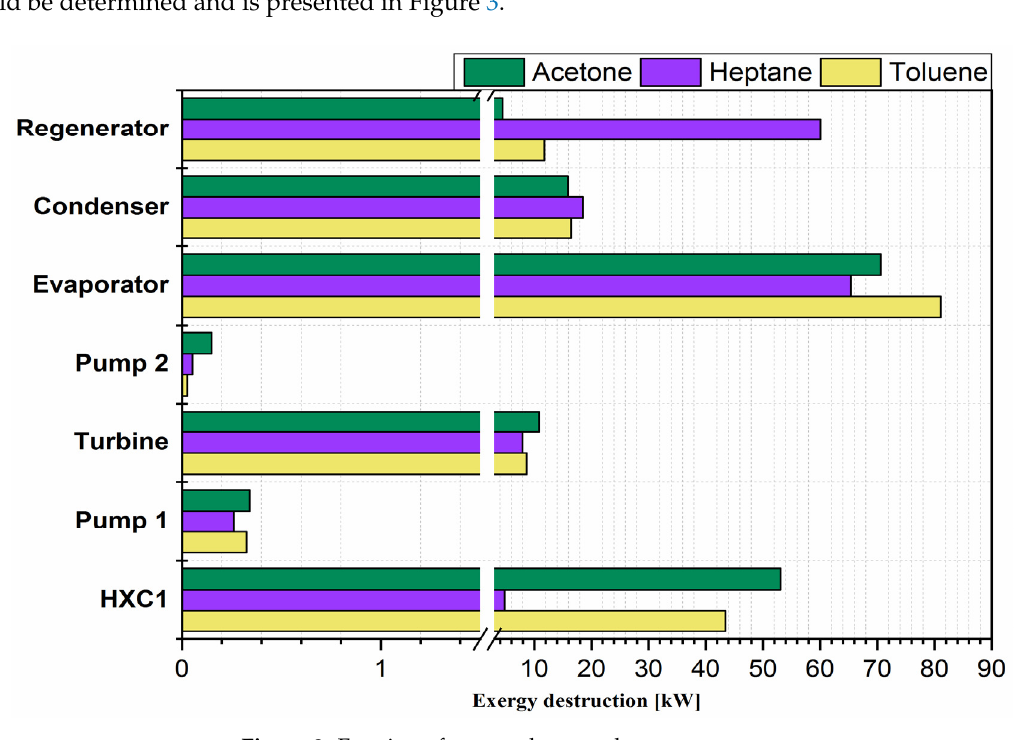
Figure 3. Fraction of exergy destroyed per component.